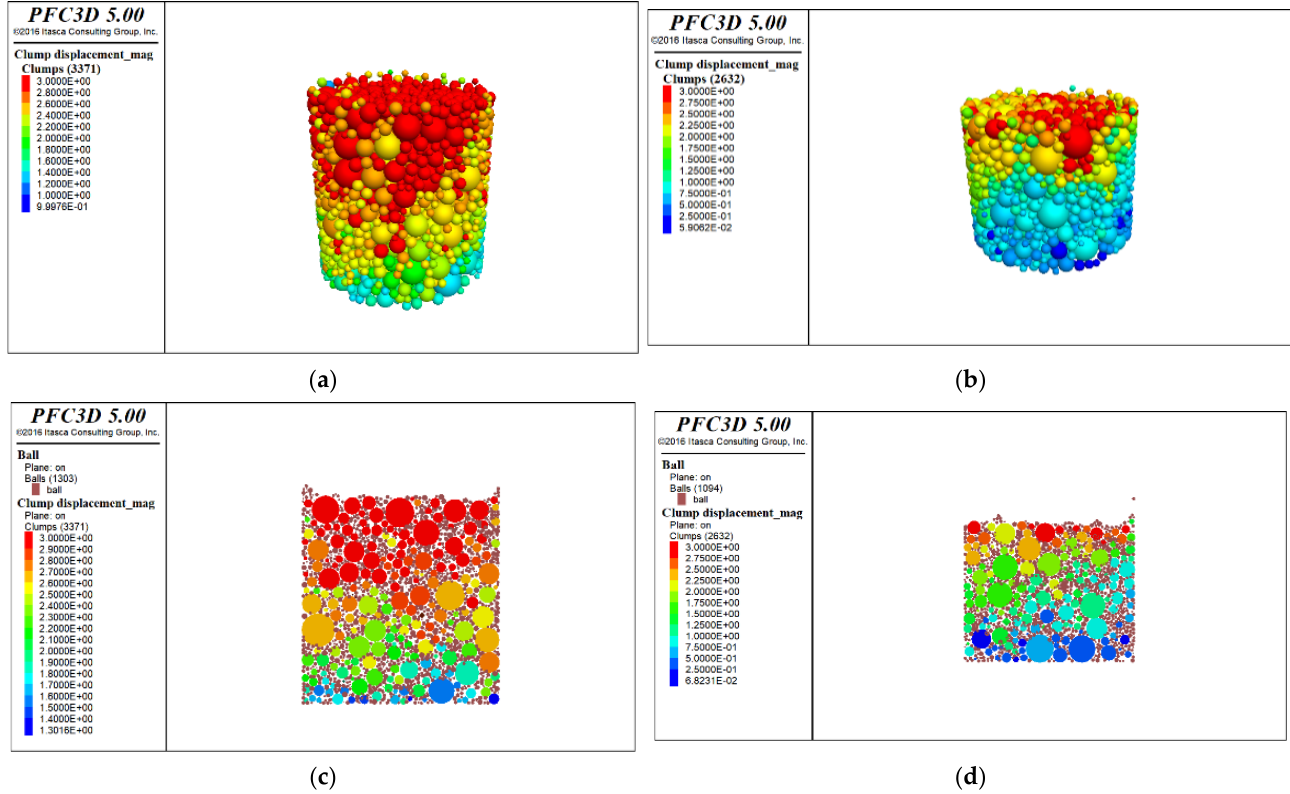
Figure 11. Comparison of skeleton particle displacement in specimens after molding. ( a ) Particle displacement of vibration specimen; ( b ) particle displacement of compaction specimen; ( c ) particle displacement of vibration specimen slice; and ( d ) particle displacement of compaction specimen slice. In the figure, E is abbreviation for exponent, for example, the number 3E0 stands for 3.